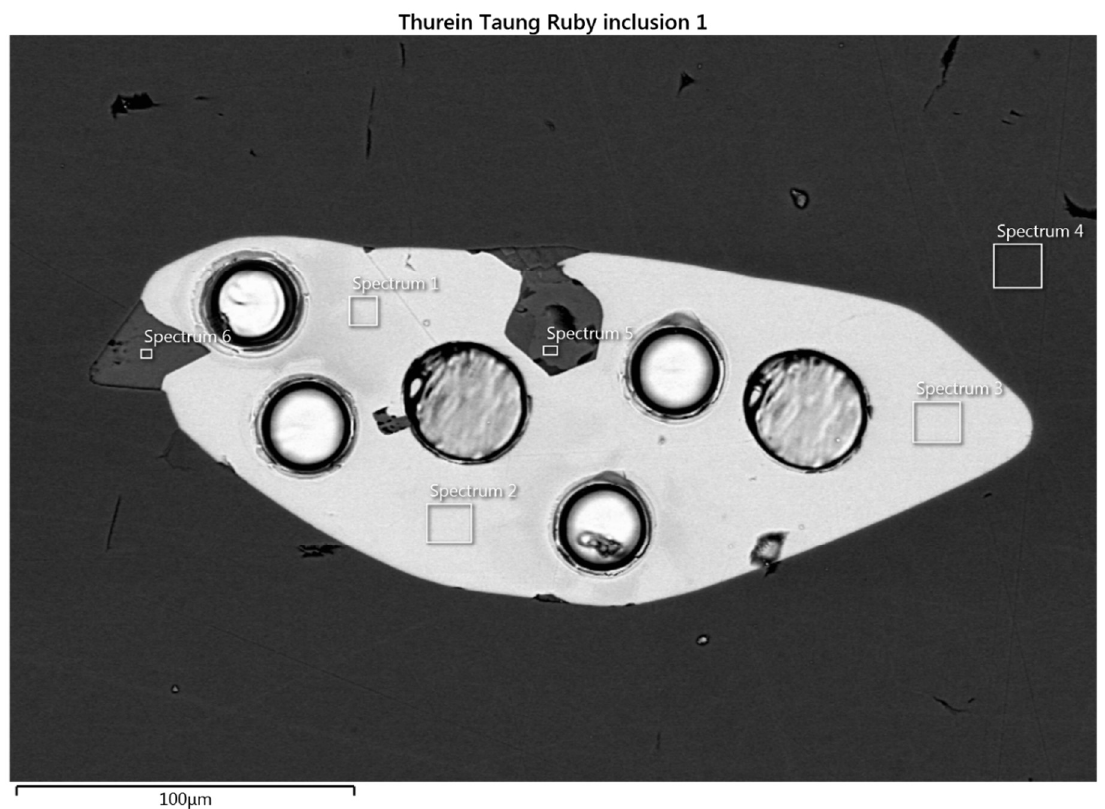
Figure 13. BSE image of titanite-nepheline inclusion (light grey) in Thurein Taung ruby (dark grey background). Darker euhedral indents in the inclusion (top and left) are nepheline. Circular pits mark age-dating sites, while EDS spectrum sites (rectangular boxes) represent titanite analyses, listed in Table 2).